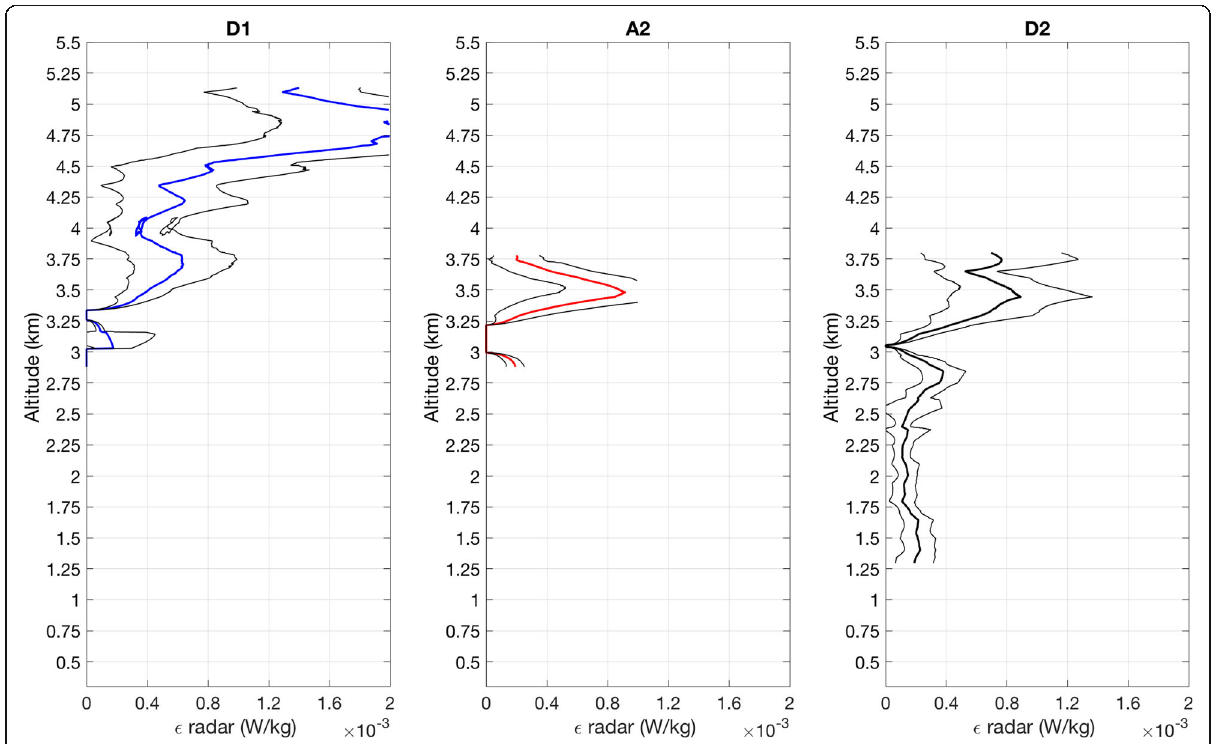
Fig. 20 Vertical profiles of ε radar during D1 ( left panel ), A2 ( middle panel ), and D2 ( right panel ) of UAV 17. Thick lines show 11-point (55 s) running means. The thin black lines show the lower and upper bounds on the estimated ε radar